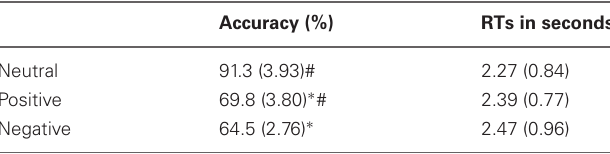
Table 3 | Mean accuracy and response times for the Count the t’s task in Experiment